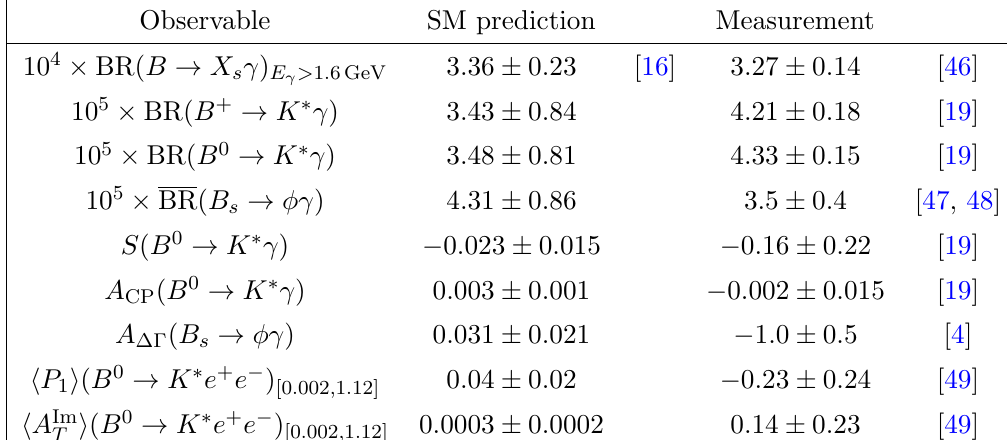
Table 2 . SM predictions vs. experimental world averages of observables sensitive to the b s(cid:13)